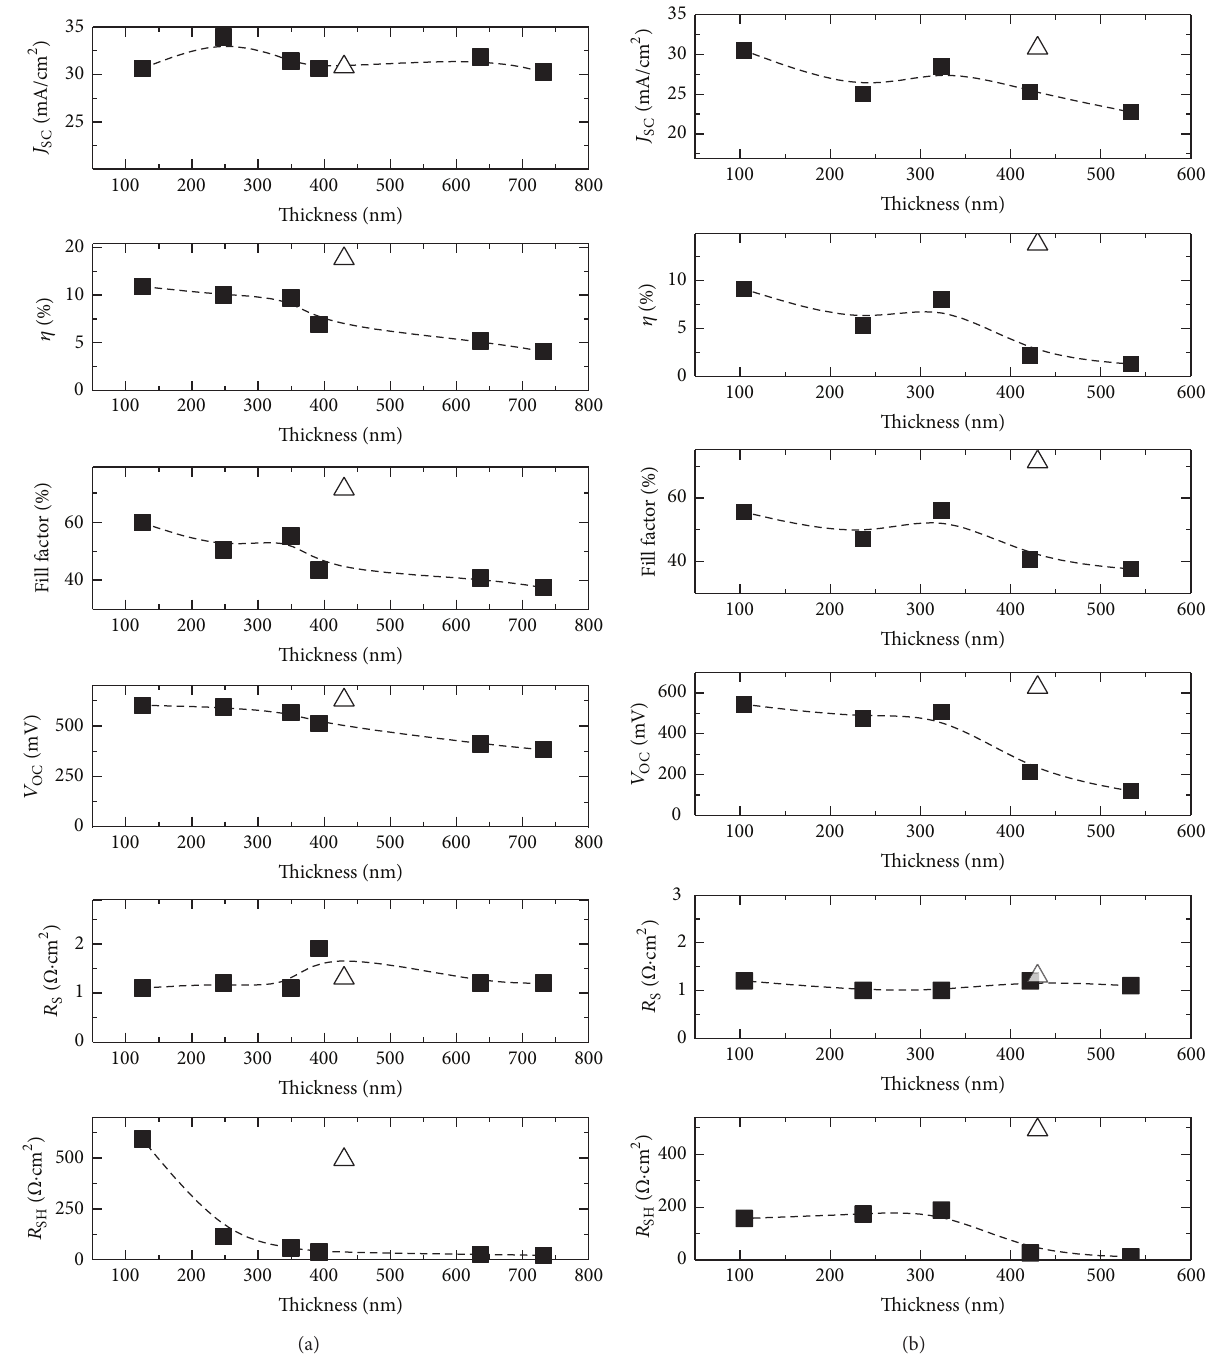
Figure 2: Variation of short circuit density ( 𝐽 ), fill factor (FF), conversion efficiency ( 𝜂 ), open circuit voltage ( 𝑉 sc ) as a function of ZnO:Al layer thickness for (a) low thermal budget and (b) high thermal budget conditions. Solar and shunt resistance ( 𝑅 SH cell parameters of the reference cell are indicated by the open triangles. Dashed lines are used as a guide to the